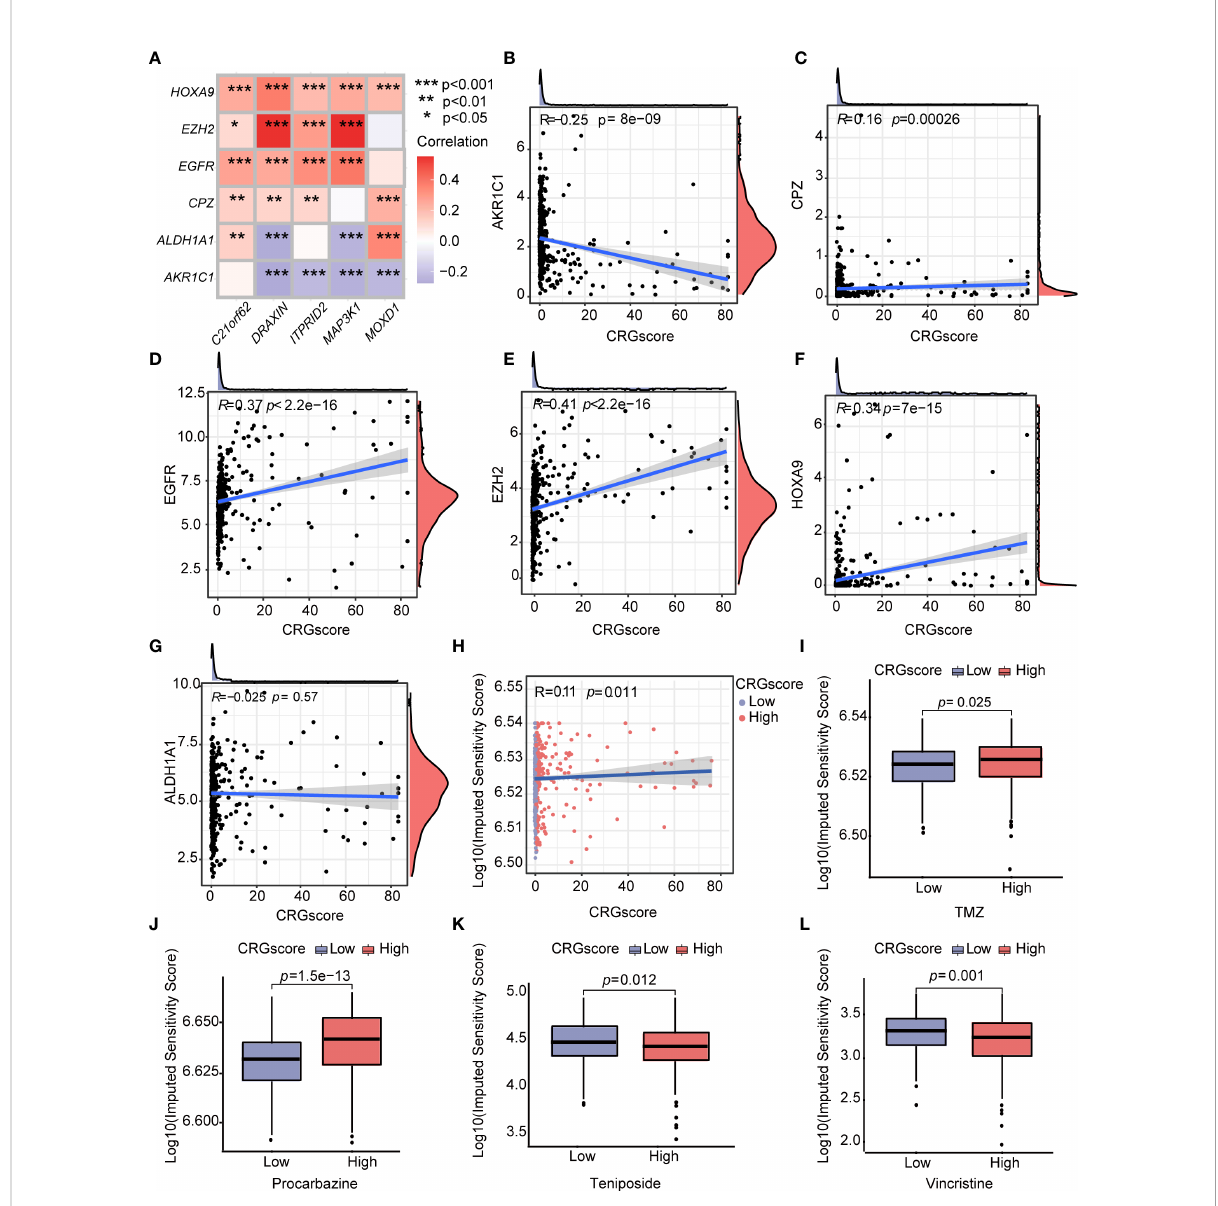
FIGURE 12 Correlations of the CRG score with CRSGs and chemotherapeutic sensitivity in LGG. (A) Correlations between the expression of CRSGs and fi ve genes in the cuproptosis-related prognostic model. (B – G) Correlations between the expression of CRSGs and the CRG score. (H) Correlations between the imputed sensitivity score of TMZ and the CRG score. (I – L) Difference in chemotherapeutic sensitivity between high- and low-risk groups. P -values were shown as: * P <0.05; ** P <0.01; *** P <0.001. CRSGs, chemoradiotherapy sensitivity – related genes; CRGs, cuproptosis- related genes; TMZ,